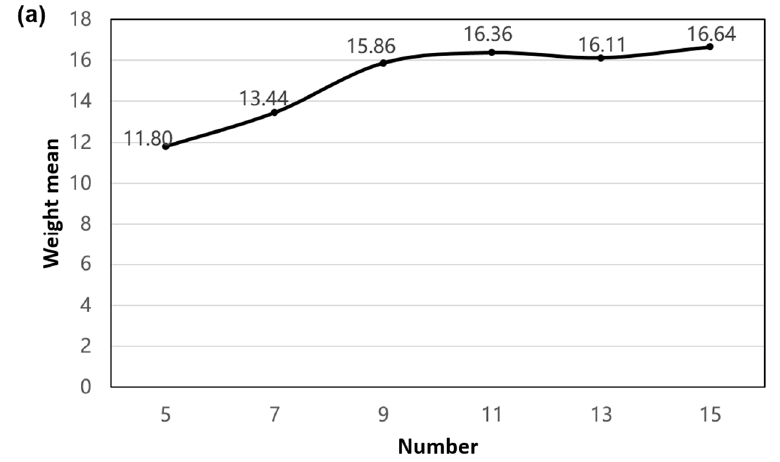
Figure 7. Density statistics chart of grid cells: ( a ) result of commercial-intersection KDE and ( b ) result of planar KDE.